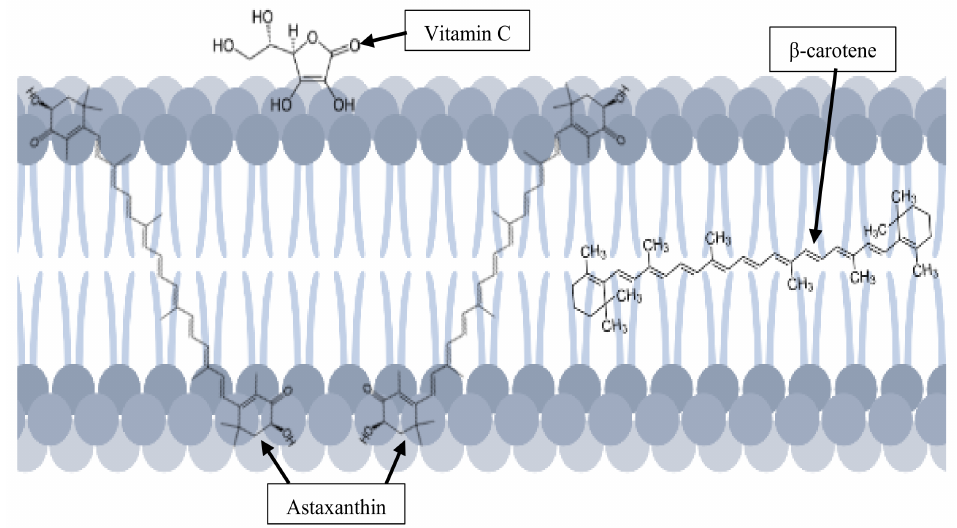
Figure 3. Unique position of astaxanthin in the cell